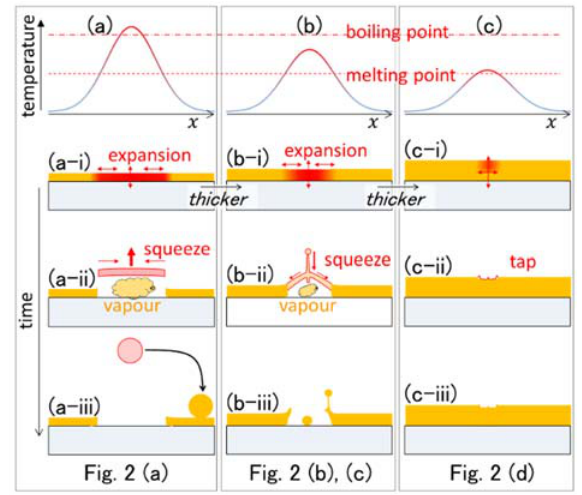
Figure 5. Schematic illustration of the solid ‐ liquid ‐ solid (SLS) process. Each panel illustrates the temporal change of a spot in an interference pattern. The correspondence with the results shown in Figure 2 is noted on the bottom. From ( a – c ), the thickness of the film is listed as following: ( a ), 40 nm; ( b ), 50 and 60 nm; ( c ), 100 nm.